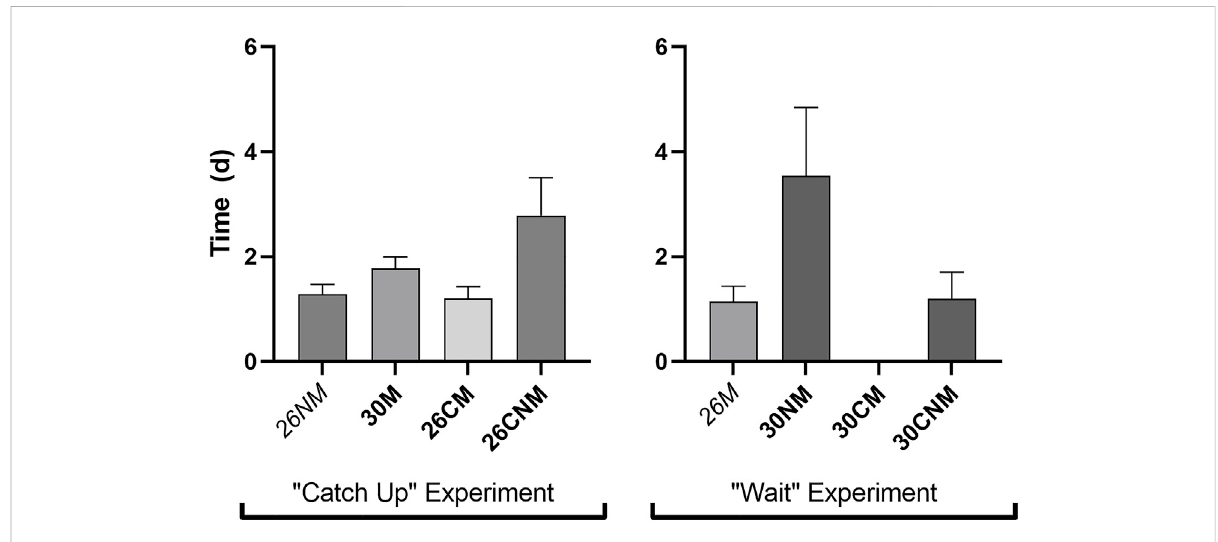
FIGURE 3 Time (d) required to reach the drift fence for early-hatching embryos versus their corresponding controls and/or sibs. The two early-hatching treatments in the two experiments expected to require the most time to disperse are